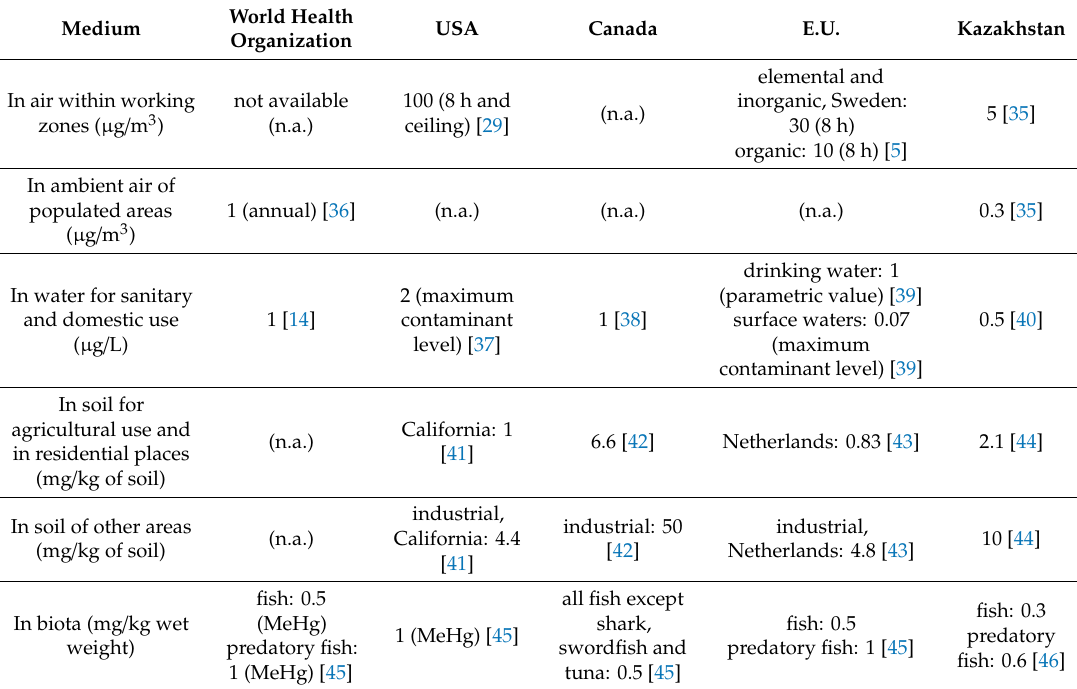
Table 1. Maximal permissible concentrations of mercury.